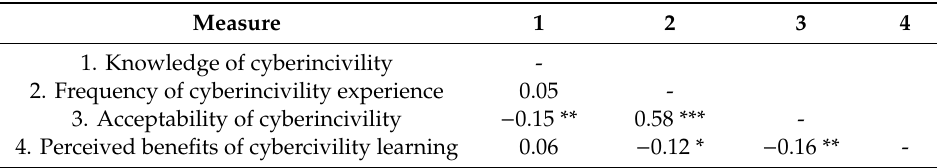
Table 6. Correlations between cyberincivility